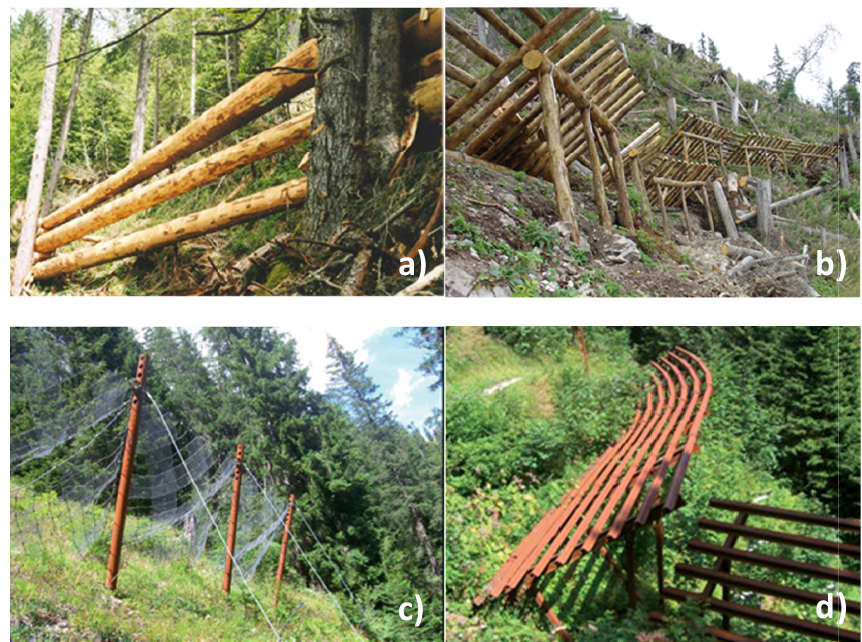
Fig. 2: Av Fig. 2. Avalanche protection measures: (a) wooden stems, (b) wooden grills, (c) steel nets, and (d) steel bridges. (Photos (a) and (b): Forestry Department of Canton Berne, Natural Hazards Division, Interlaken.)